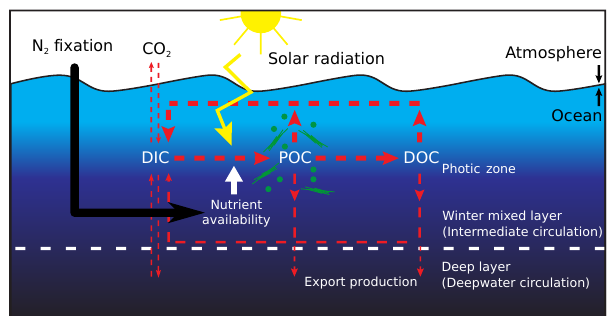
Figure 1. Major C fluxes for a biological pump budget and the main role of N 2 fixation. Biological pump is the C transfer into the ocean interior by biological processes. DIC is dissolved inorganic C, POC is particulate organic C, and DOC is dissolved inorganic C. See Moutin et al. (2012) for a detailed